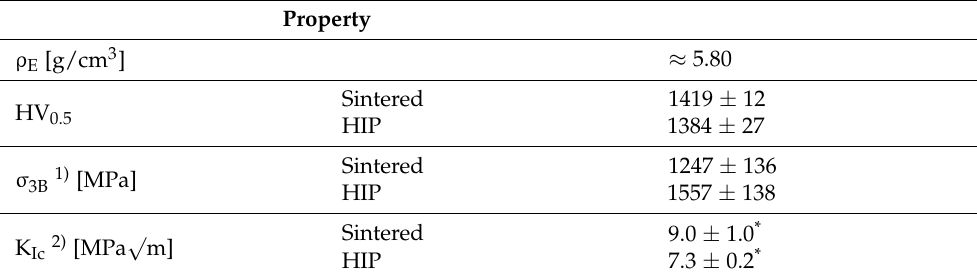
Table 6. Typical mechanical properties of ZYA10P.